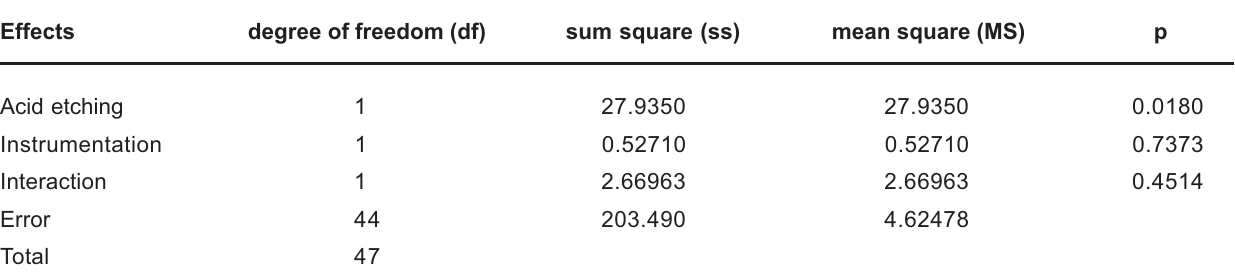
TABLE 2- Bond strength means for the test groups (ANOVA, p=0.05)